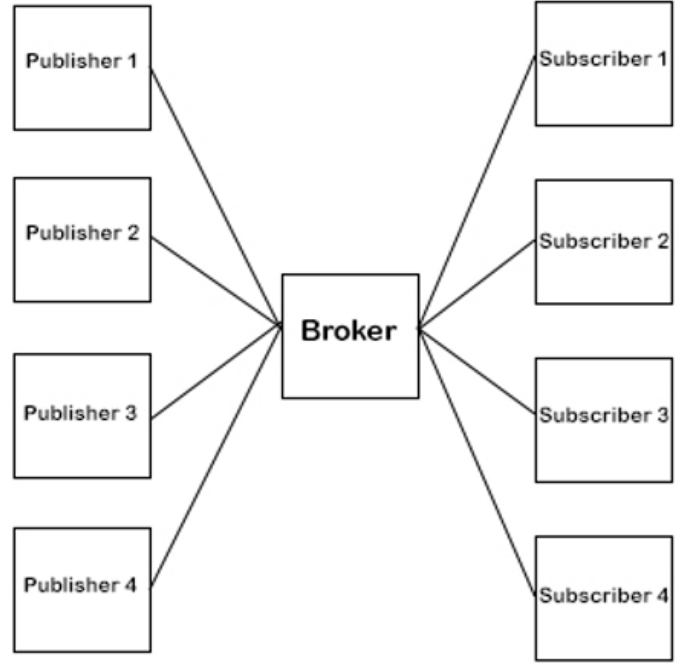
Figure 8. Publish/Subscribe communication